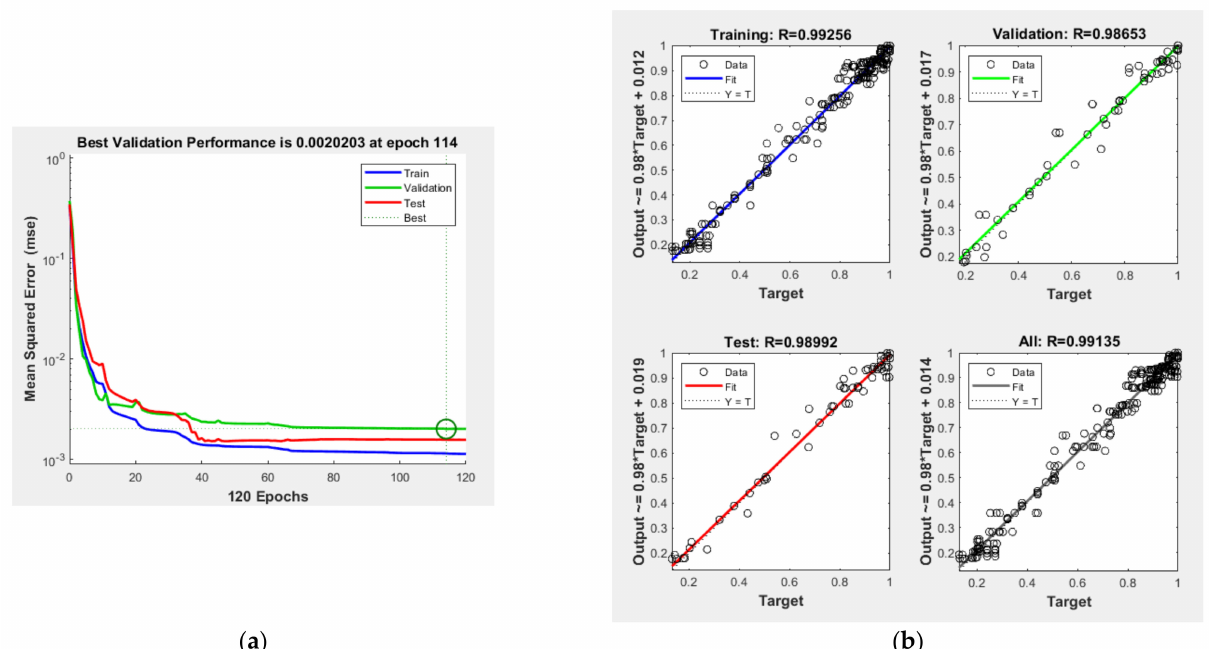
Figure 1. The best performance of the ANN ( a ) and the ANN fit goodness ( b ). 3.2. MOGA